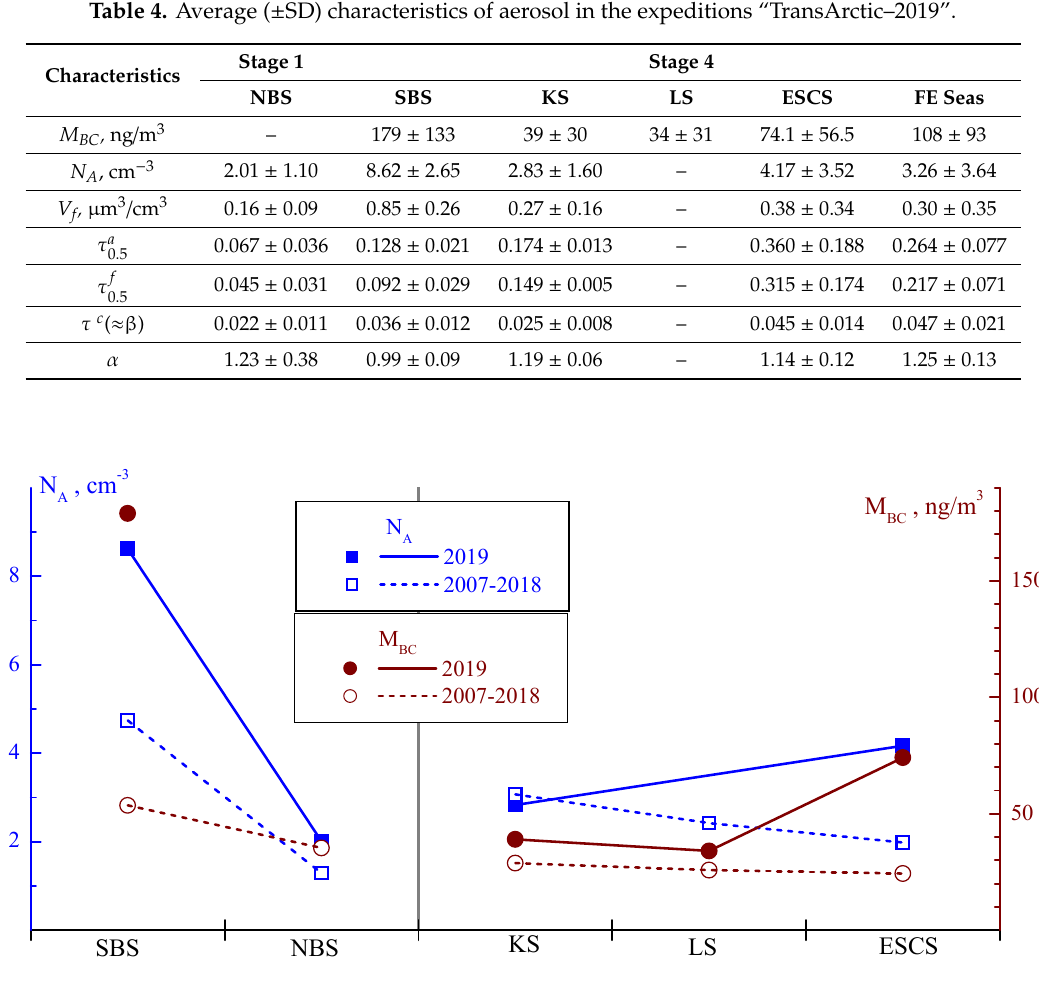
Figure 7. Average concentrations N A and M BC in five regions of the Arctic Ocean (NBS, SBS, KS, LS,